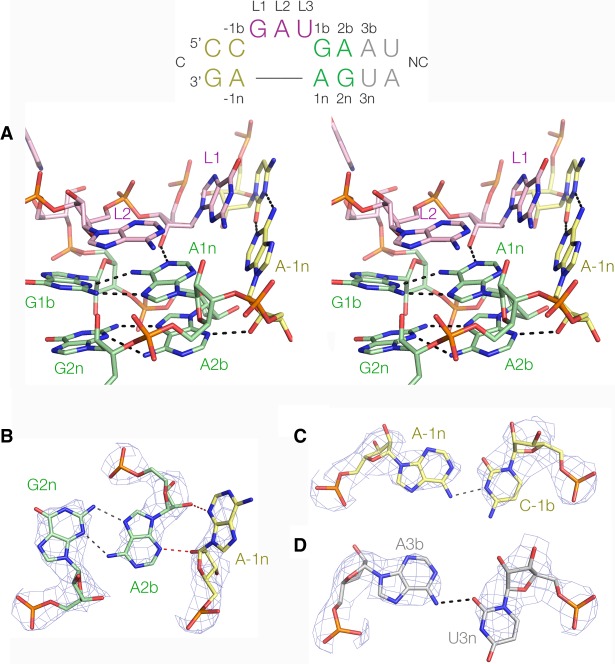
The structure of the A. fulgidus 5′-UTR k-turn in complex with L7Ae. The sequence and nucleotide nomenclature for the k-turn is shown at the top. (A) A parallel-eye stereoscopic image of the core of the k-turn. The RNA adopts the conformation of a standard, simple k-turn with two trans-sugar-Hoogsteen G:A base pairs and cross-strand hydrogen bonds from the O2′ groups of L1 and −1n ribose to the nucleobases of A1n and A2b, respectively. B through D show details from the structure with electron density from the 2Fo−Fc map contoured at 2.5 σ. (B) The A2b:G2n base pair and its interaction with A-1n. A-1n N3 accepts a hydrogen bond from A2b O2′, and its O2′ donates one to A2b N3. The A2b:G2n base pair is associated by two hydrogen bonds. This k-turn is therefore a standard N3 structure (Daldrop and Lilley 2013). (C) The C-1b:A-1n base pair. This forms a cis base pair associated by a single hydrogen bond from A-1n N6 to C-1b N3. (D) The A3b:U3n base pair. This forms a trans base pair associated by a single hydrogen bond from A3b N6 to U3n O2.